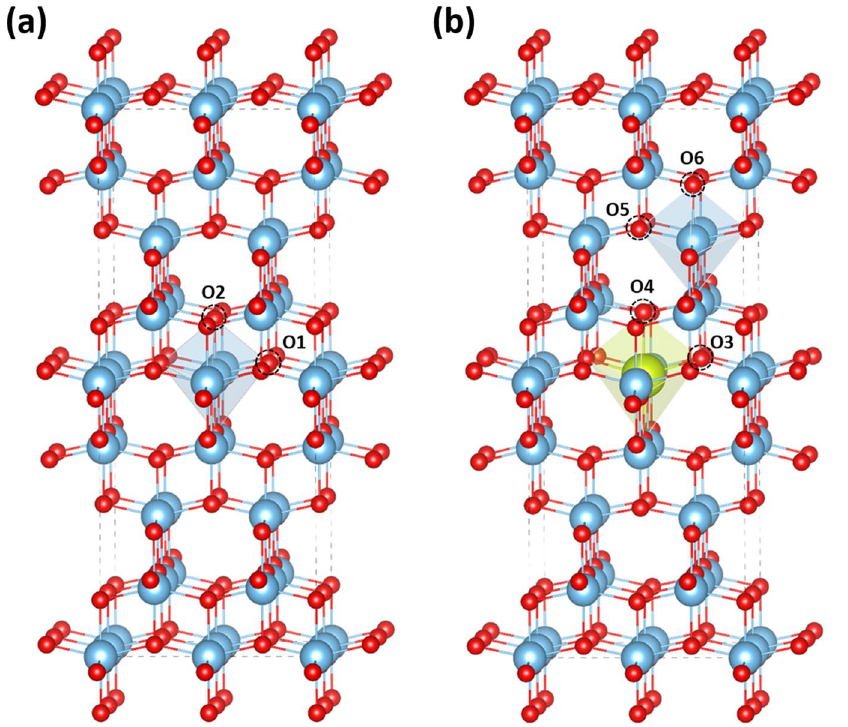
Figure 6. Schematic view of undoped and Ce-doped anatase TiO 2 . ( a ) The possible O vacancy sites V O1 and V O2 in a [TiO 6 ] octahedron of the undoped TiO 2 . Note that V O1 and V O2 are symmetrically equivalent in the crystal structure of TiO 2 . ( b ) The possible O vacancy sites V O3 , V O4 , V O5 , and V O6 of the Ce-doped TiO 2 . Vacancies sites V O3 , V O4 are in a [CeO 6 ] octahedron, whereas V O5 , and V O6 sites are in the next-nearest- neighboring [TiO 6 ] octahedron. The large blue balls, large green balls, and small red balls represent the Ti, Ce, and O atoms, respectively. The [TiO 6 ] and [CeO 6 ] octahedrons are shown in blue and green, respectively. This figure was drawn by using the VESTA 3 software 20 . https:// jp- miner als. org/ vesta/ en/ downl oad.